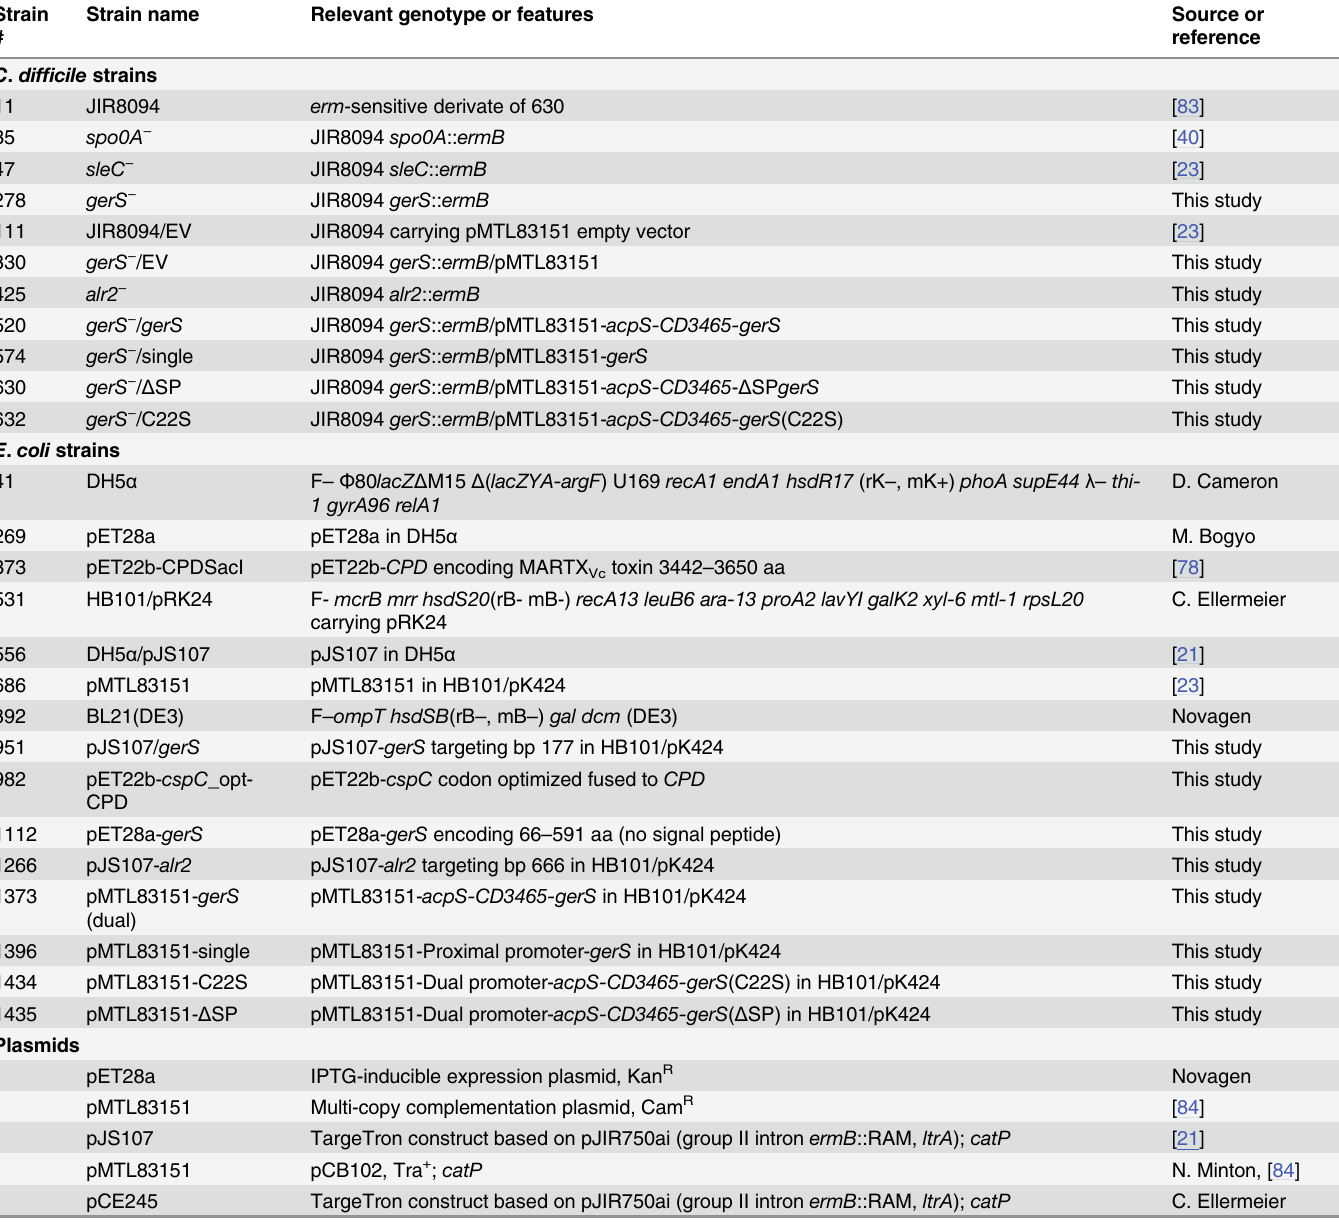
Table 1. Strains and Plasmids used in this